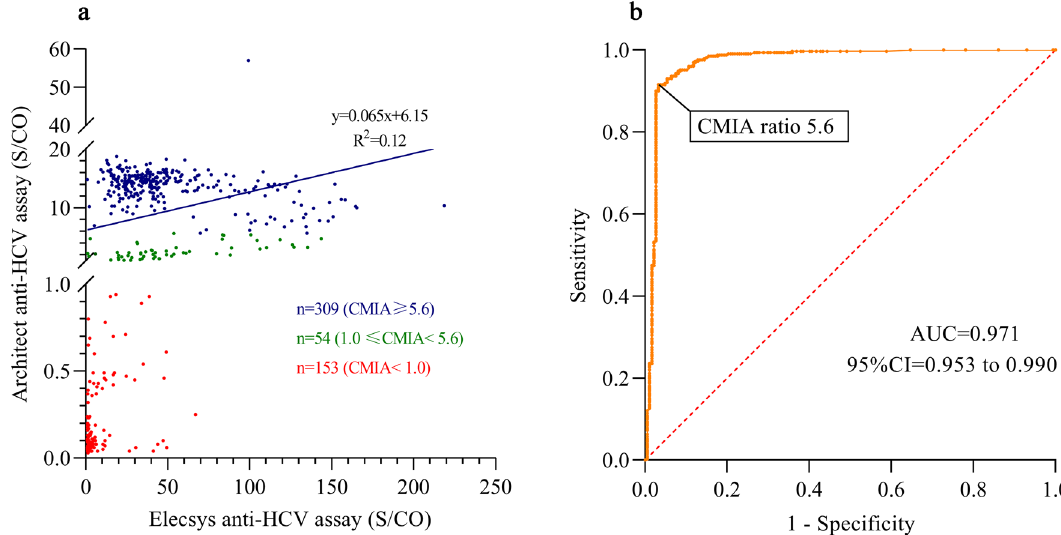
Figure 2. ( a ) Scatter plots of the anti-HCV S/CO ratios of the Elecsys and Architect assays.